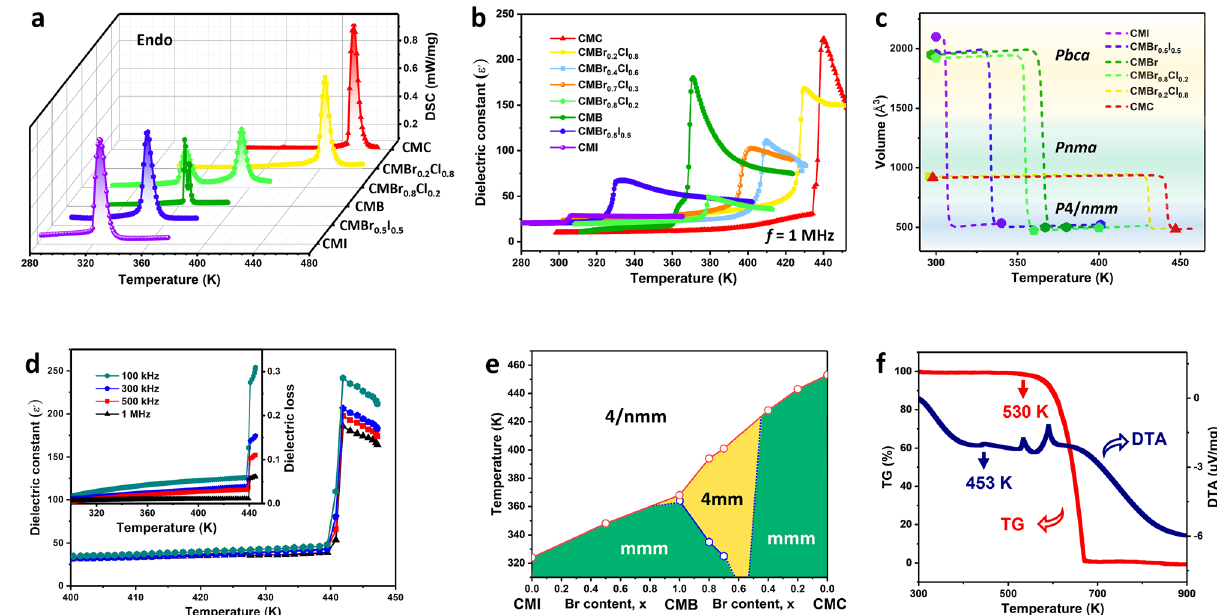
measured at different frequencies for CMC. e Phase diagram and the point groups of CMBr x I 1 − x and CMBr x Cl 1 − x solid solutions. The dotted boundary is roughly esti- mated due to the dif fi culty of growing homogeneous crystals. f TG/DTA curves of CMC with heating rate